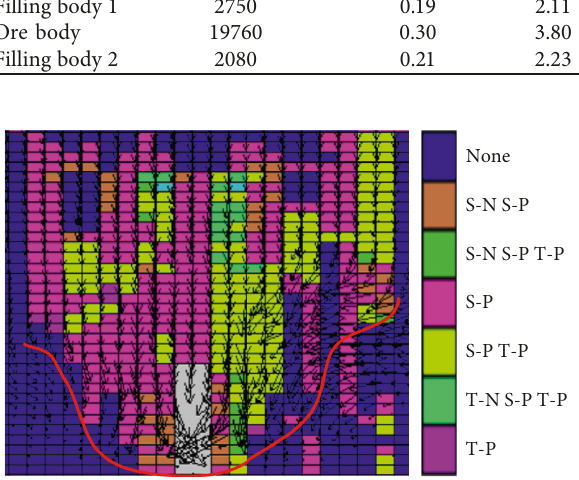
Figure 8: Plastic zone of instability of the mining collapse area.